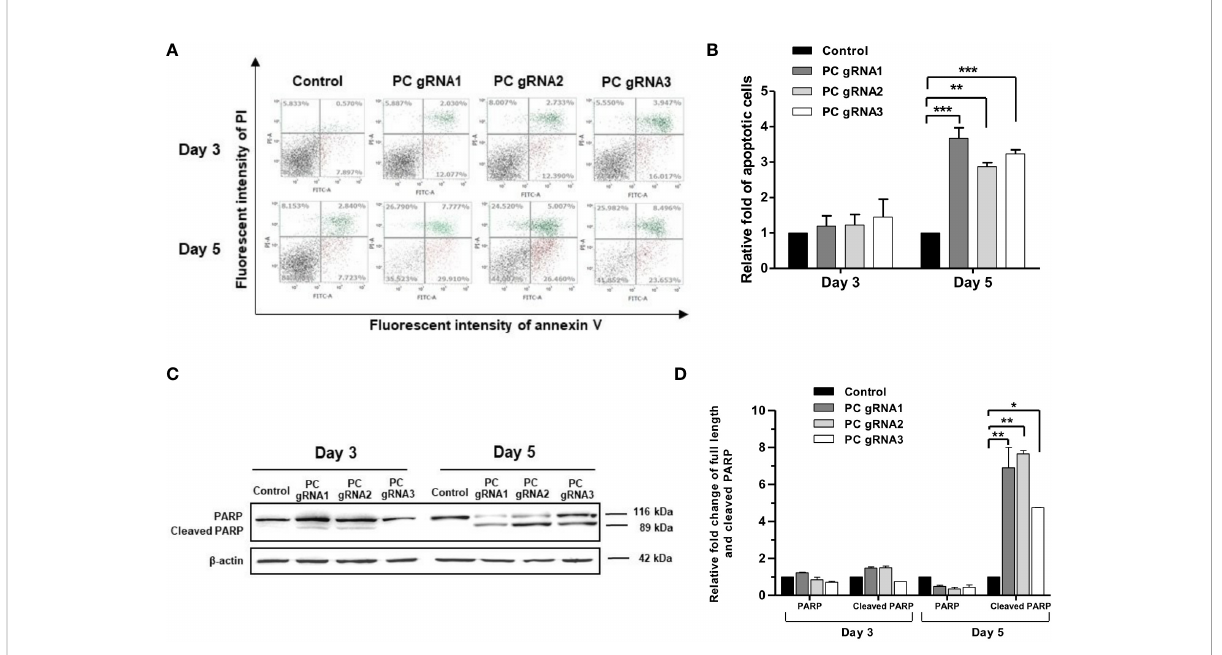
FIGURE 4 Apoptotic induction in PC KO HT-29 cells. (A) Distribution of cell population of PC KO HT-29 cells in live (bottom left), early apoptosis (bottom right), late apoptosis (top right) and dead (top left) at days 3 and 5, respectively. Y-axis is the fl uorescent intensity of propidium iodide (PI) which stains DNA and X-axis is the fl uorescent intensity of annexin V, an apoptotic marker. (B) Relative fold change of apoptotic cells is shown as means ± SD from three independent experiments. (C) Representative Western immunoblot of full-length and cleaved PARP in each PC KO HT- 29 cell line at days 3 and 5. (D) Relative abundance of full length and cleaved PARP bands after normalizing with b -actin. The relative full length and cleaved PARP bands in each PC KO clone were relative to that of HT-29 cells transfected with an empty vector (control), which was arbitrarily set to 1 at each time point. *p <0.05, **p < 0.01, ***p <